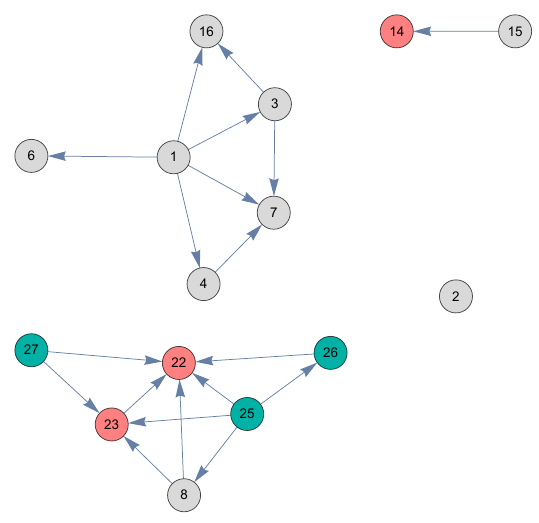
Figure 1 . The interrelationships between the different (equivalence classes of) planes. An arrow from i to j indicates that P associated with i is coloured red then every g If the dot is coloured green then every g g i ’s with global anomalies are removed (i.e. k = 25 , 26 or 27